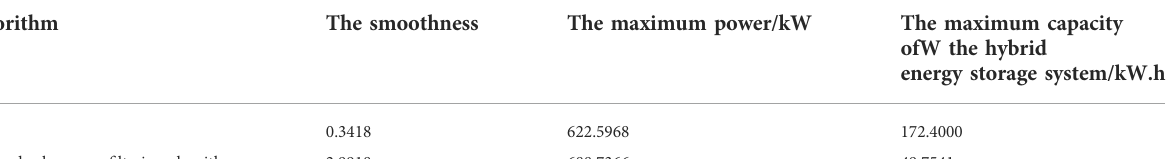
TABLE 3 Comparison of the smoothing results of the three algorithms.